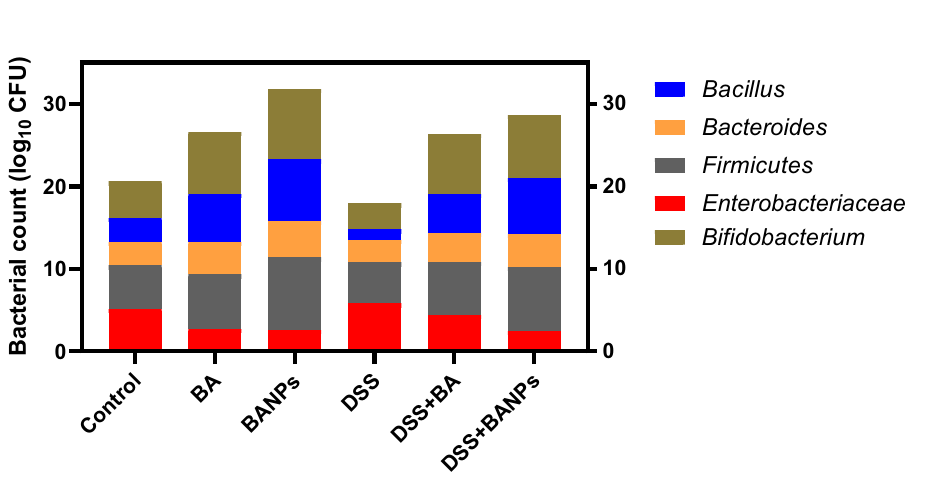
Figure 7. Effects of orally administered B. amyloliquefaciens (BA) or BA-nanoparticles (BANPs) in non-colitic and colitic rats on abundance of Bacillus , Bacteroides , Firmicutes , Enterobacteriaceae and Bifidobacterium populations (log 10 CFU), 7 days post DSS induction. Non-colitic groups including Control, BA and BANPs groups where rats were orally gavaged PBS, B. amyloliquefaciens and B. amyloliquefaciens loaded nanoparticles (BA at level of 1.0 × 10 10 CFU/kg in 1 mL of PBS/rat/day), respectively, for 7 days. Colitic groups: DSS, BA and BANPs groups where rats were orally gavaged dextrane sodium sulphate (DSS), B. amyloliquefaciens + DSS and B. amyloliquefaciens loaded nanoparticles (BA at level of 1.0 × 10 10 CFU/kg in 1 mL of PBS/rat/day) + DSS , respectively, for 7 days. All groups orally gavaged by 5%